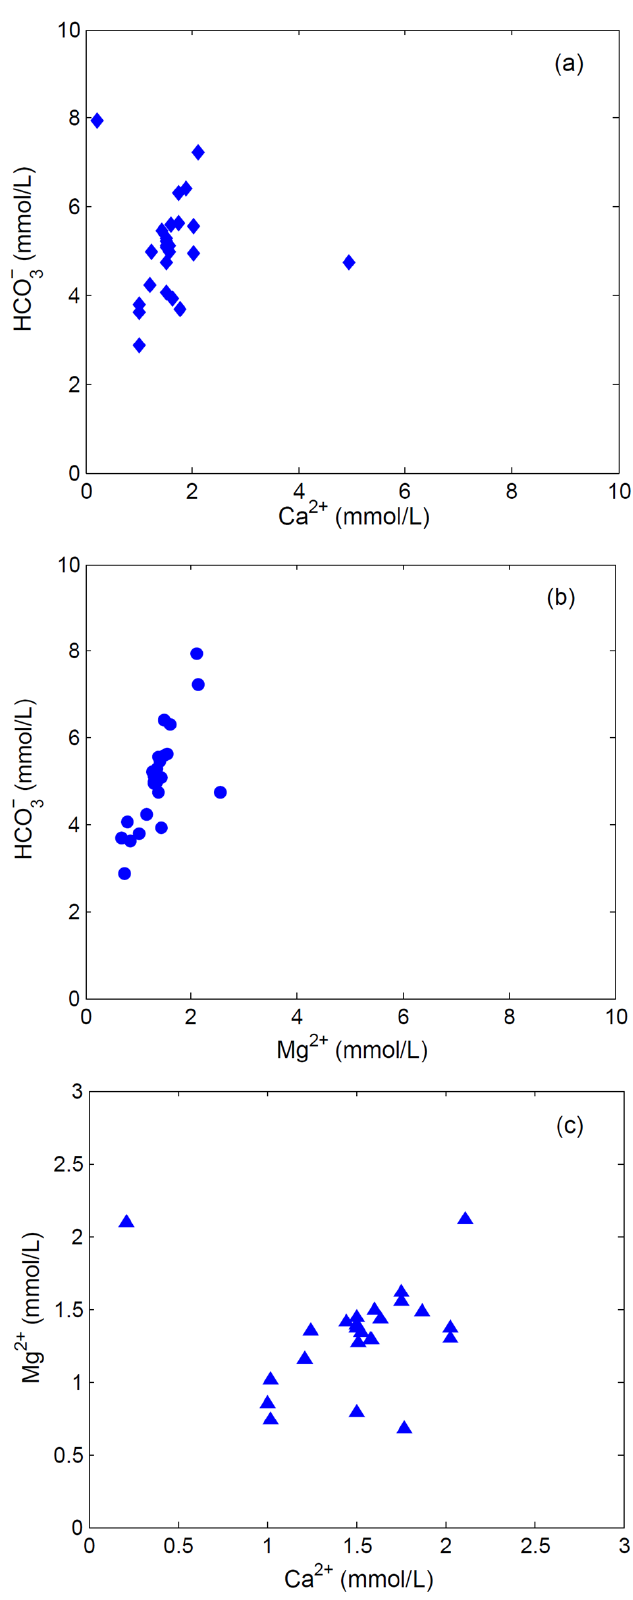
Figure 2. Correlation between ( a ) Ca 2 + and HCO 3 − ; ( b ) Mg 2 + and HCO 3 − ; ( c ) Ca 2 + and Mg 2 + ions in the karst groundwater samples collected from the studied dolomite aquifer between 2008 and